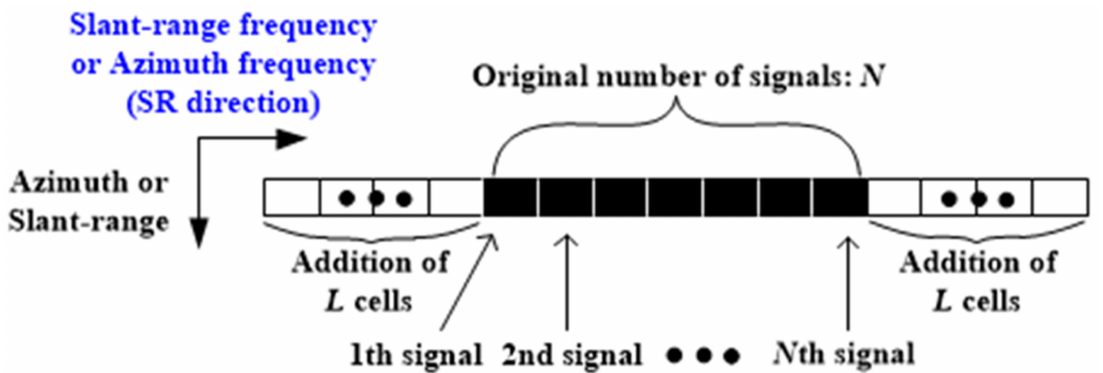
Figure 4. Increase in the number of cells in SR